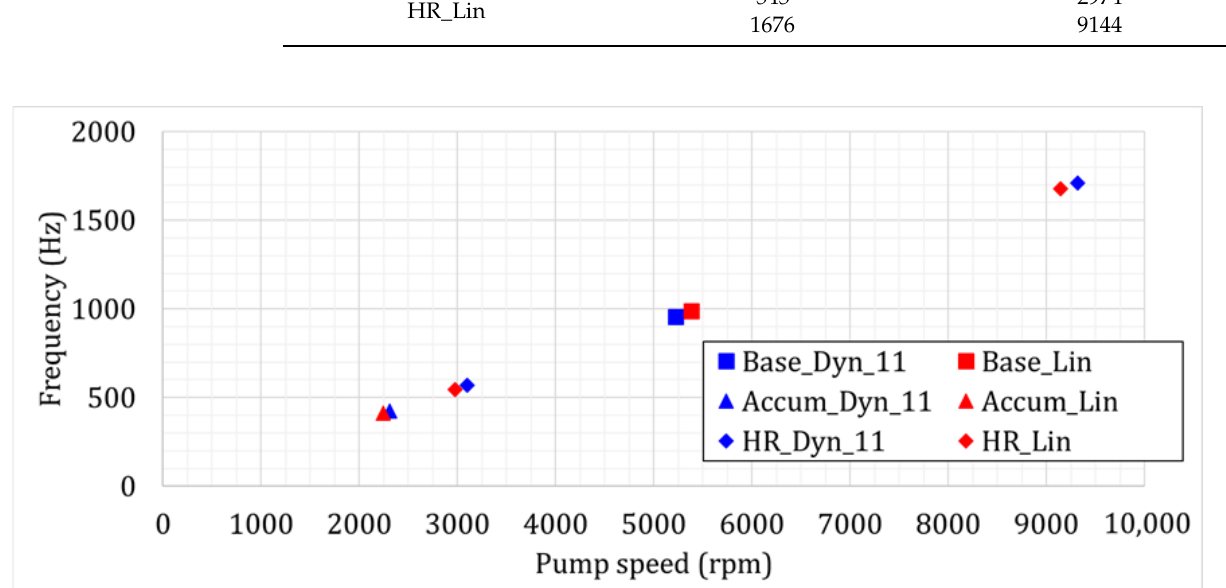
Figure 15. Resonance prediction: dynamic vs. linear analysis.